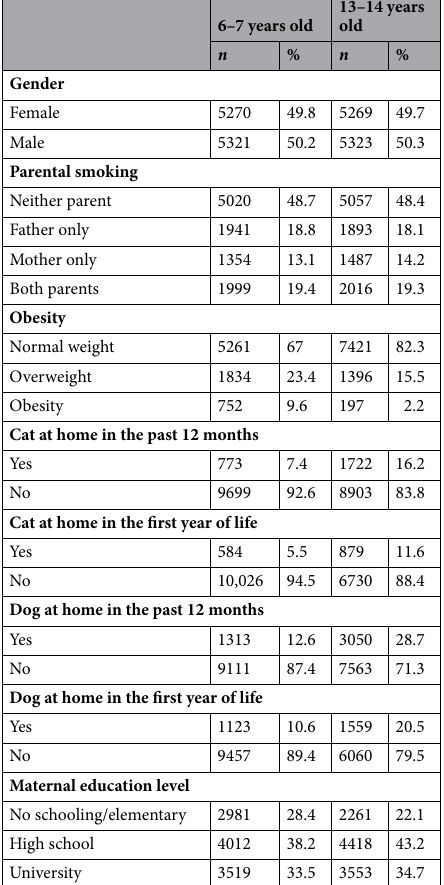
Table 2. Main characteristics of the children and prevalence of risk factors. n : number of